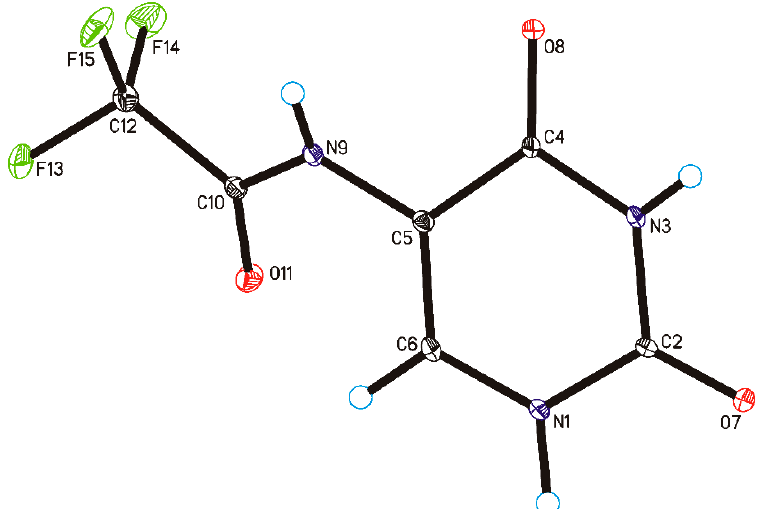
Figure 3. Molecular structure of 5-( N -trifluoromethylcarboxy) aminouracil, showing the atom-labeling scheme (displacement ellipsoids are drawn at the 25% probability level, and H-atoms are shown as small spheres of arbitrary radius).